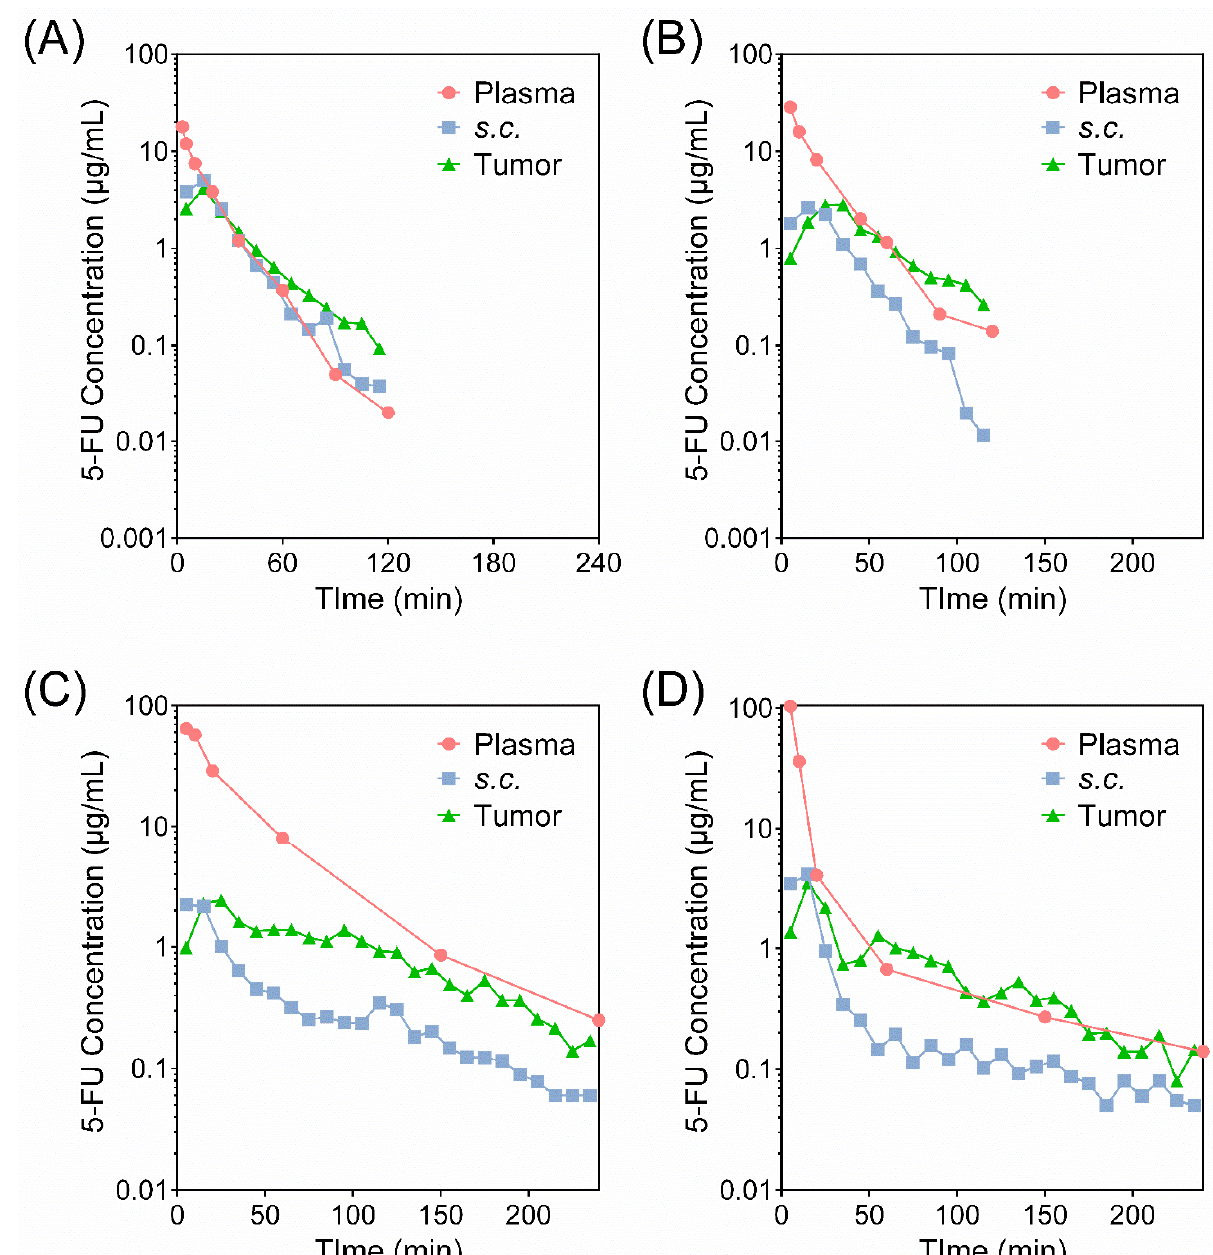
Figure 3. Concentrations of 5-FU versus time in plasma and the ECF of healthy s.c. tissue and tumor tissue following i.v. administration (10 mg/kg) of ( A ) 5-FU solution, ( B ) 5-FU LiPo, ( C ) 5-FU-Cu-PEI LiPo, and ( D ) 5-FU-Cu-PEI LiPo+. Mean values are plotted on logarithmic–linear coordinates ( n ≥ 5). Inclusion of 5-FU within liposomes prolonged drug exposure within plasma and tu-